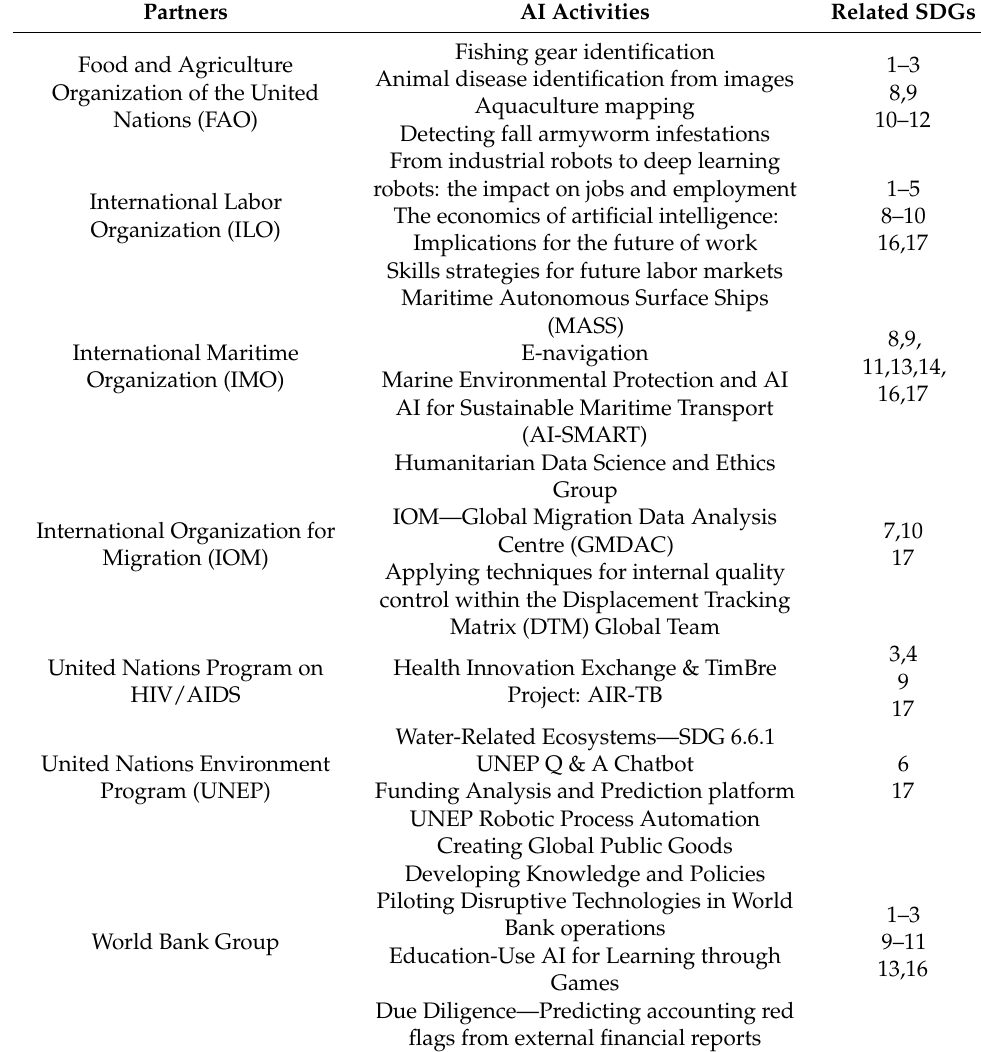
Table 5. UN activities on artificial intelligence (AI) and relationship with the